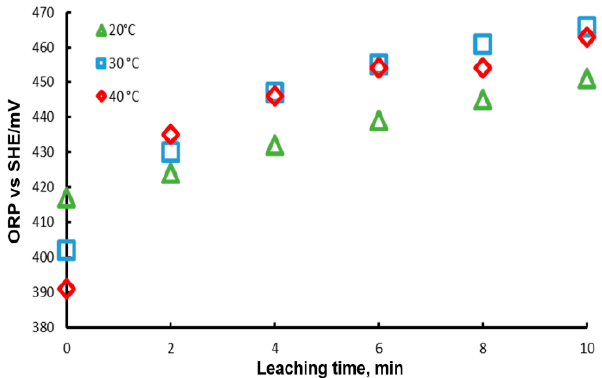
Figure 8. ORP variation during lead dissolution from pure galena at different temperatures. Exper- imental conditions: particle size: − 149/+74.1 g of mineral, 0.1 L of solution, 0.3 M 𝑁𝑎 (cid:2871) 𝐶𝑖𝑡 , 0.6 M 𝐻 (cid:2870) 𝑂 (cid:2870) .